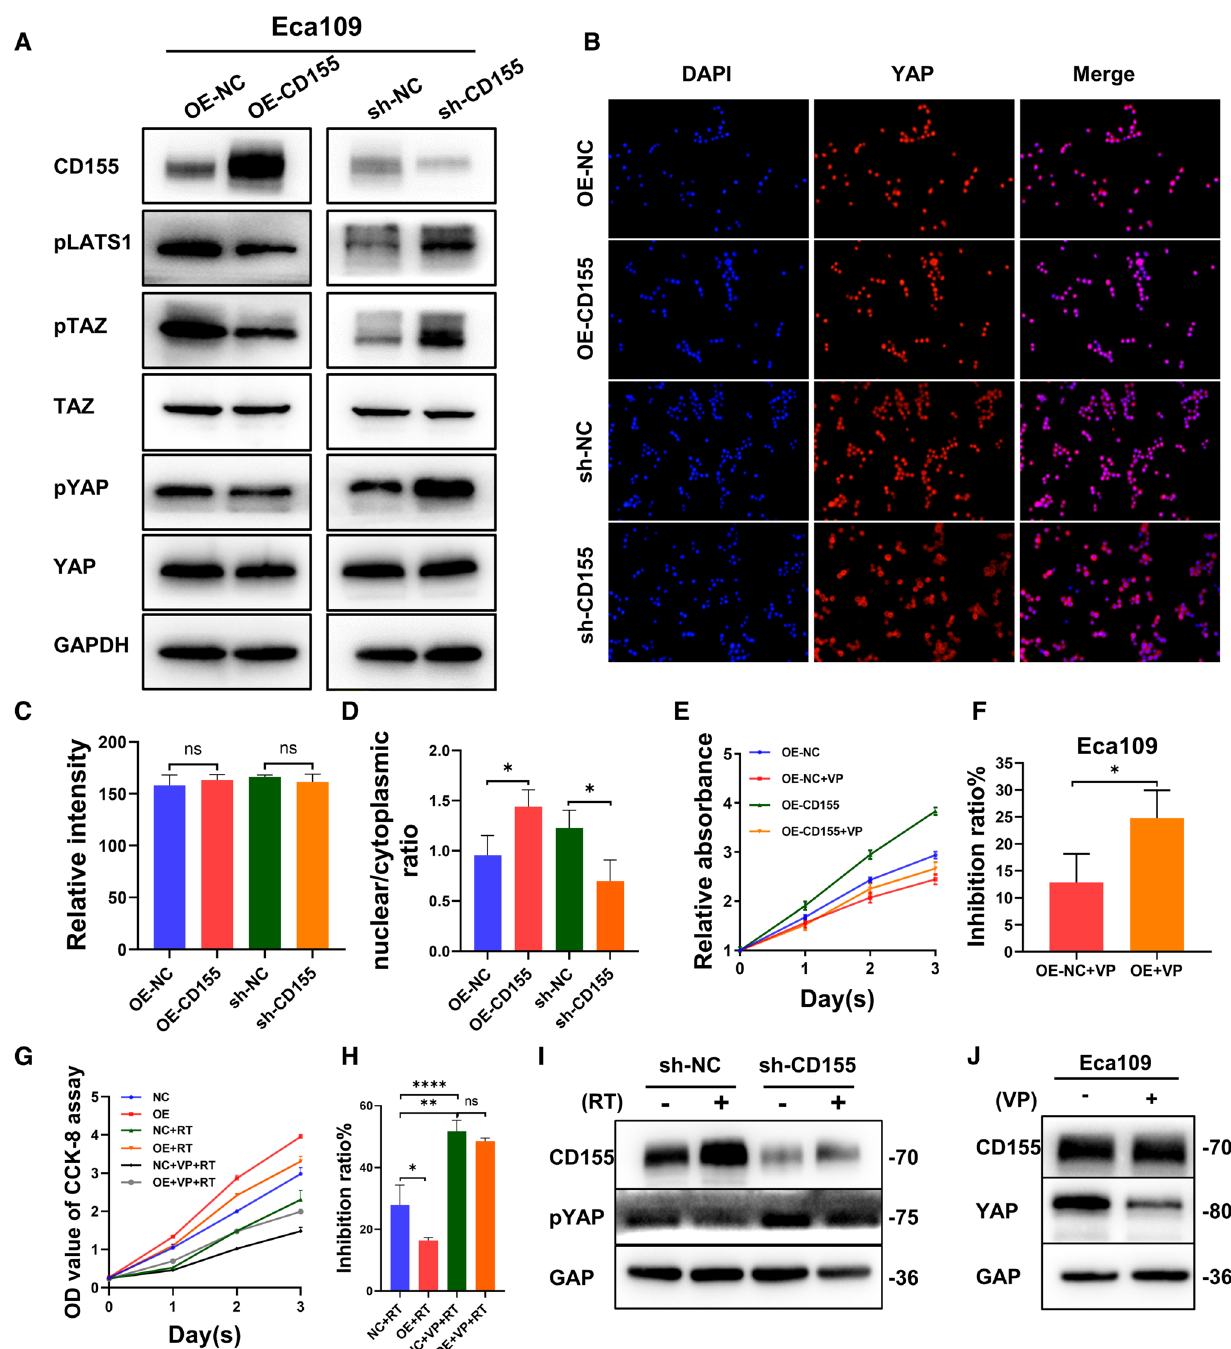
Fig. 5 CD155 stimulates EC cellular proliferation and migration through the Hippo signaling pathway. A Western blot analysis of CD155, pLATS1, pTAZ, TAZ, pYAP, and YAP in cells overexpressing or depleted of CD155. B Immunofluorescence analysis of YAP in cells overexpress- ing or depleted of CD155. red, YAP; blue, DAPI. C Quantification of immunofluorescence staining using ImageJ software. D Analysis of the nucleoplasmic ratio of B using ImageJ. E , F CCK8 analysis showed that verteporfin treatment reversed the pro-proliferative effect of CD155 overexpression in EC cells. G , H CCK-8 assay was performed to examine the effect of verteporfin (VP) in combination with irradiation on the proliferative capacity of esophageal cancer cell lines. I WB was performed to detect the expression levels of p-YAP and CD155 in esophageal cancer cells after irradiation. J WB for the effect of VP on CD155 and